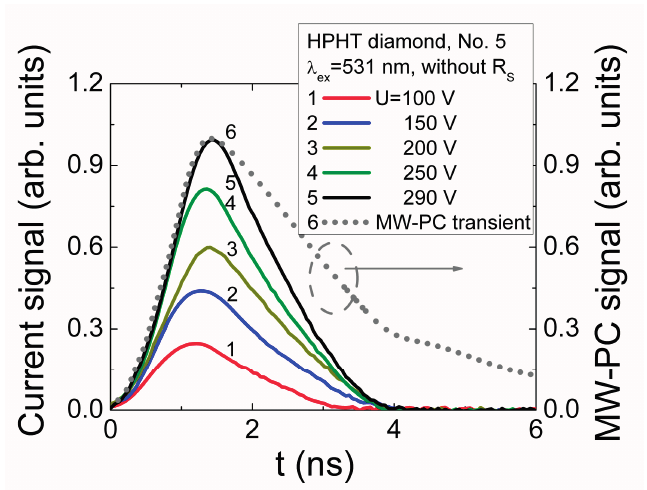
Figure 10. Variation of the induction current transients dependent on the applied voltage in a capacitor type detector made of a mosaic set of linear implanted contacts and metal electrodes containing HPHT diamond sample No. 5. Injection of excess carriers has been implemented by 531 nm light laser pulses impinging through hole in the